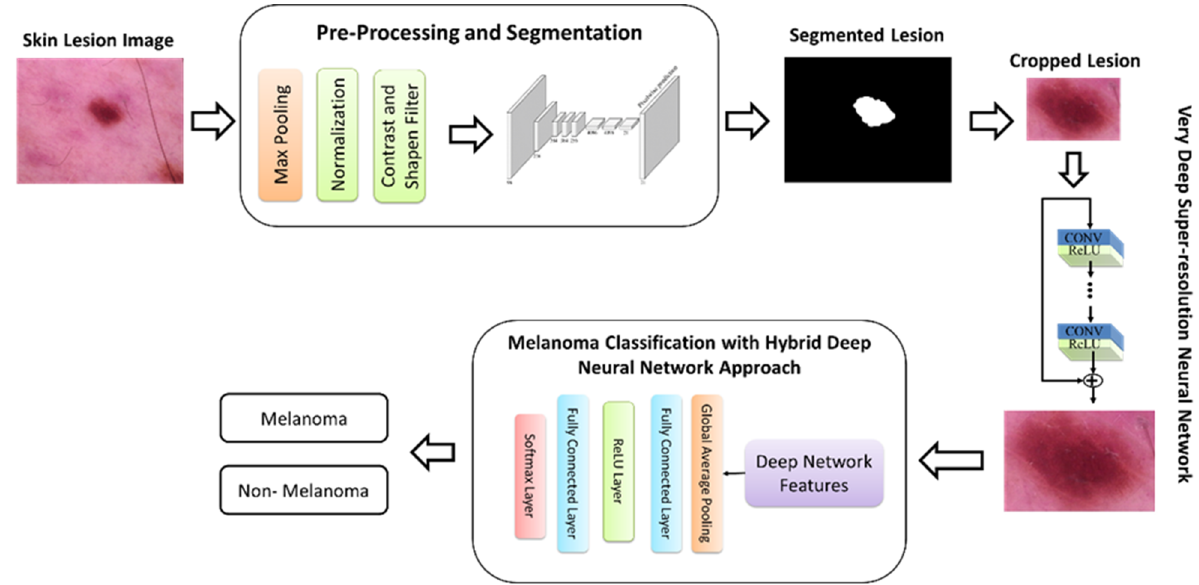
Figure 1. The proposed multi ‐ task learning network.